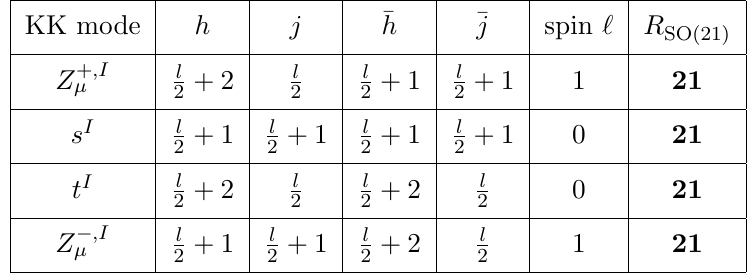
Table 3 . Kaluza-Klein modes from the spin-1 multiplet (cid:2) I